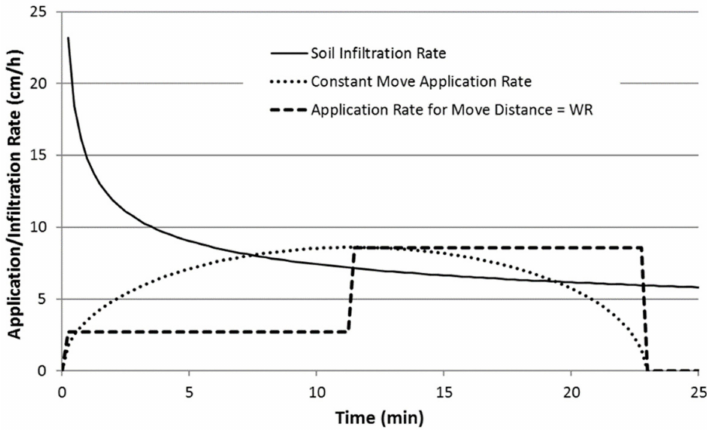
Figure 10. The application rate to a portion of soil 5% into the move distance (set to be equivalent to the wetted radius) compared to a constant move application rate for an elliptical sprinkler pattern. This can result in more runoff in this portion of soil if the soil takes water in as if it were saturated in the first half of the application